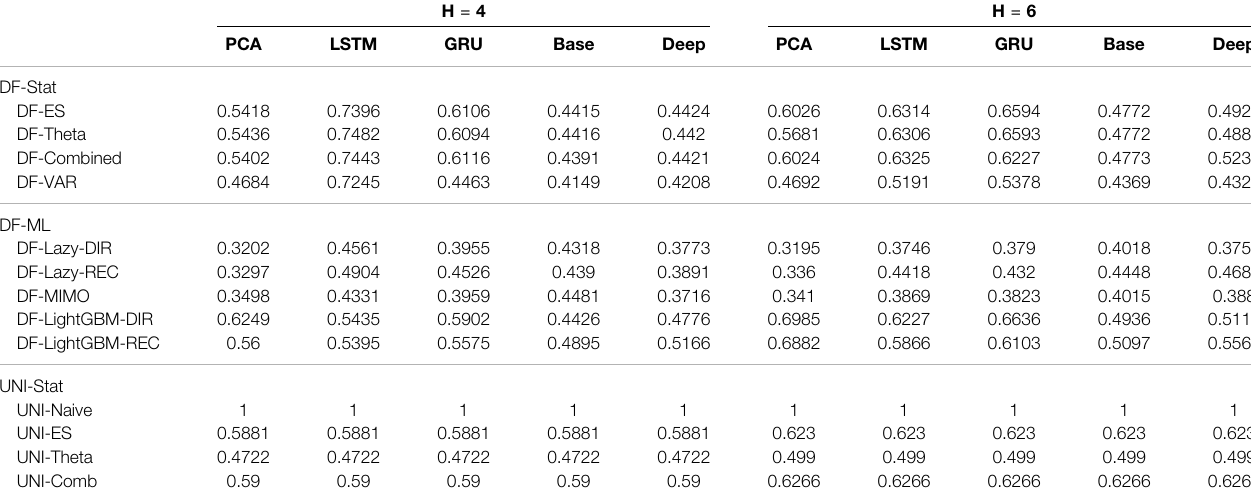
TABLE 4 | Electricity Naive Normalized MSE for H ∈ {4, 6}. The content of the cell c ij represents the model using the j th dimensionality reduction technique with the i th forecasting method. The NNMSE for the Naive method is equal to 1. An NNMSE < 1 indicates that the proposed method outperforms the Naive method. H = 4 H =